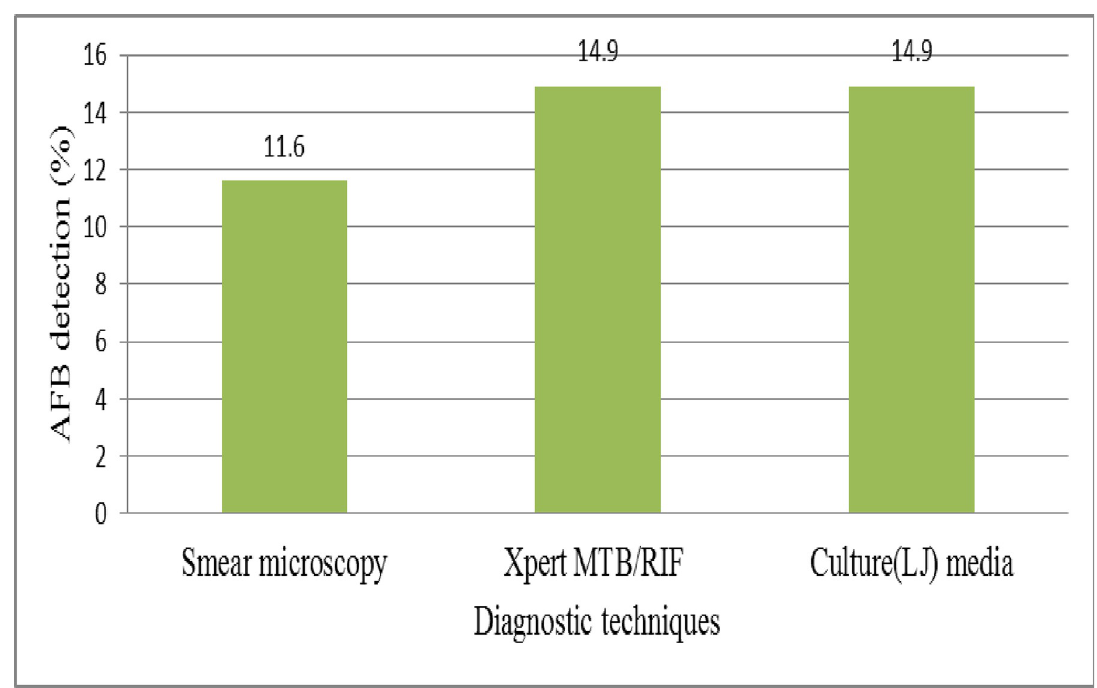
Fig 2. Magnitude of tuberculosis among PTB suspected patients in Kuyu General Hospital, 2020 (n = 242).